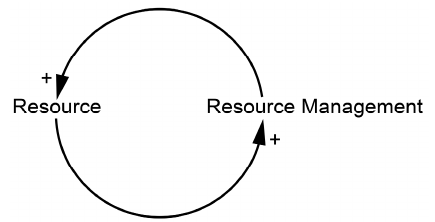
Figure 2. Reinforcing, positive feedback loop.